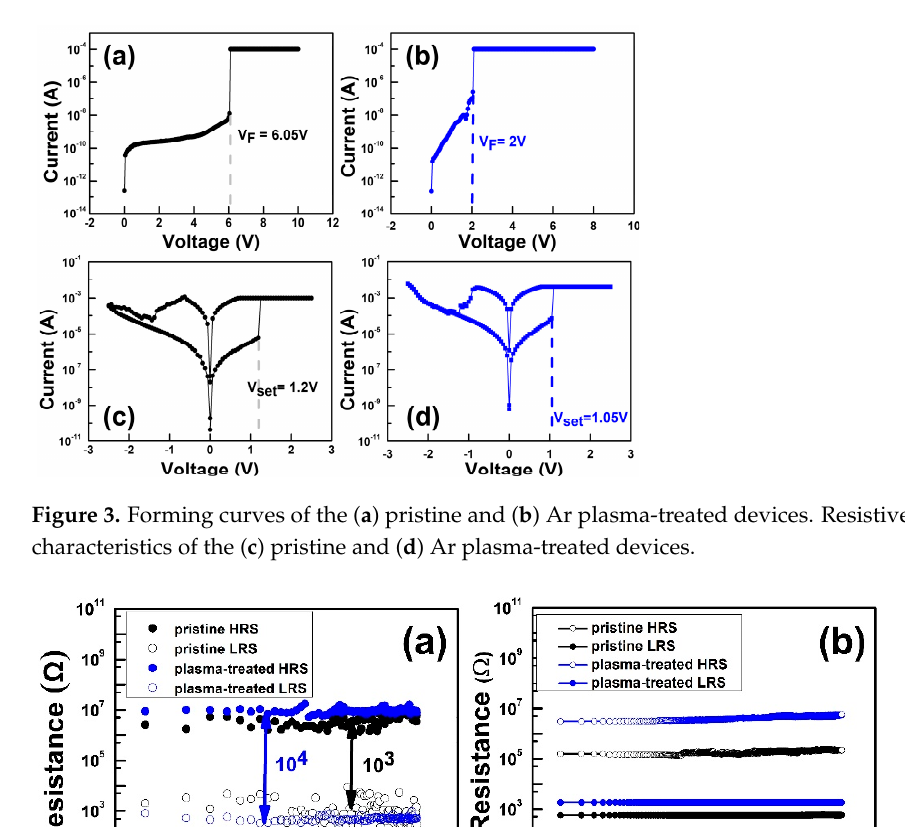
Figure 3. Forming curves of the ( a ) pristine and ( b ) Ar plasma-treated devices. Resistive switching characteristics of the ( c ) pristine and ( d ) Ar plasma-treated devices.